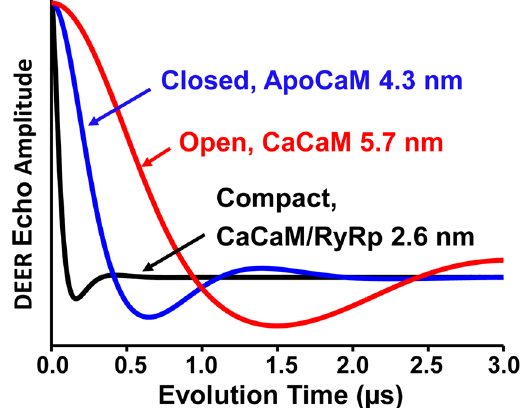
Figure 2. Simulations of DEER waveforms, based on distance predictions from structural models in Fig. 1, show that the three structural states of CaM should be clearly distinguished and resolved, with labeling sites at T34CS38C in the N lobe and R106CT110C in the C lobe. Each simulation assumed a Gaussian distance distribution with a width (FWHM) of 1.0